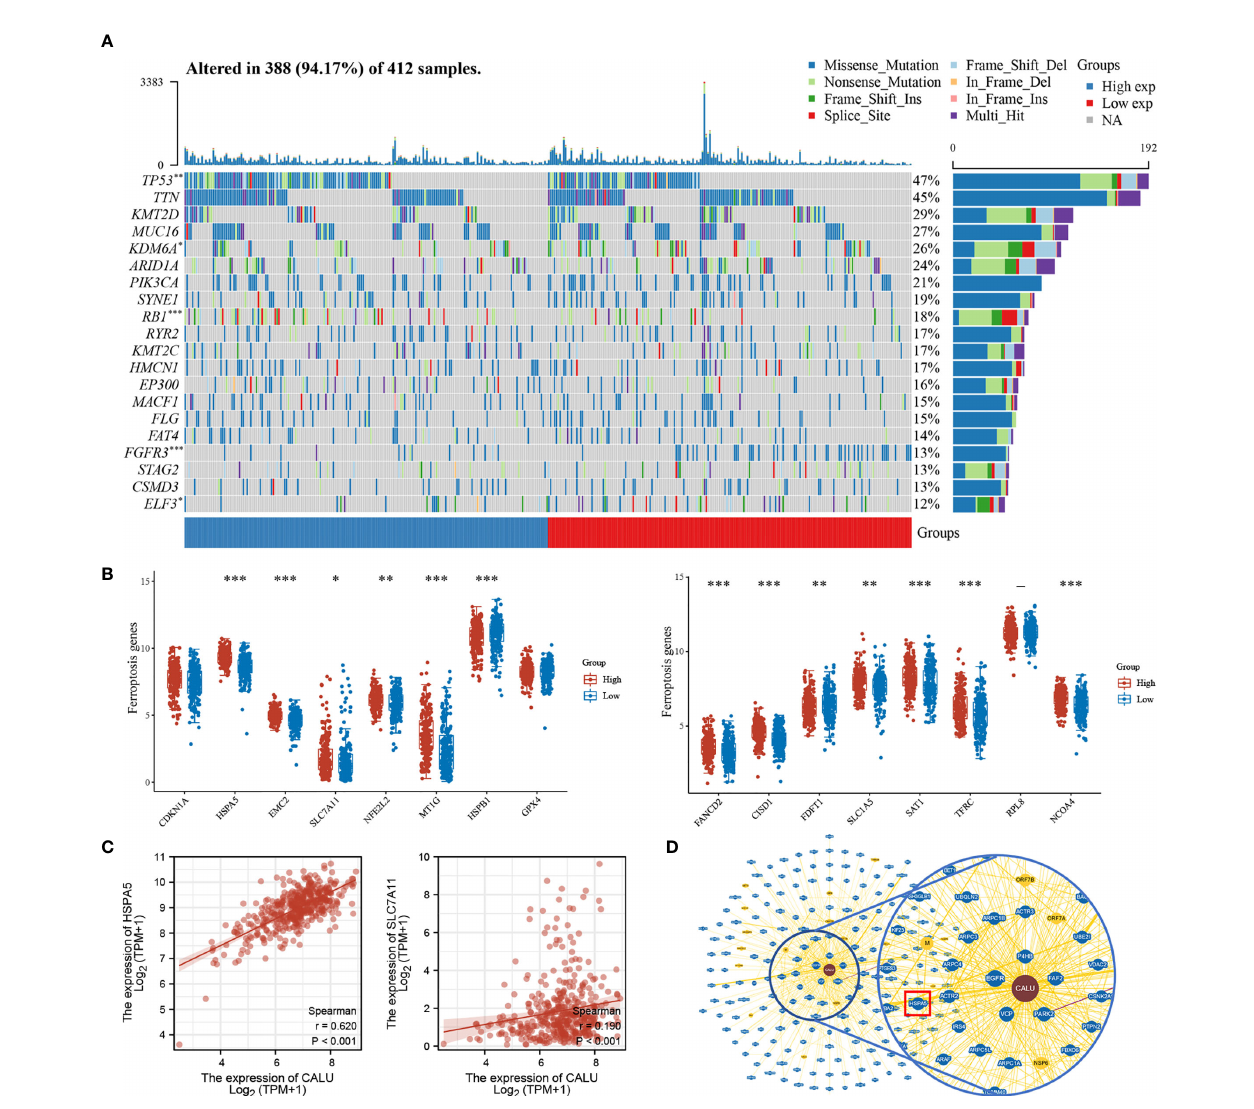
FIGURE 7 | Association of CALU with gene mutations and ferroptosis in BLCA. (A) Signi fi cant differences in mutation frequency of TP53, RB1, FGFR3 between CALU high and CALU low groups, with higher TP53(p<0.01), RB1(p<0.001) and lower FGFR3 (p<0.001), ELF3 (p<0.05) mutation rates in CALU high groups. (B, C) CALU correlates with various of ferroptosis-related genes, including HSPA5 (p<0.001, R=0.620)and SLC7A11 (p<0.001, R=0.190). (D) The protein-protein interaction network from the BioGRID database con fi rmed the interaction between CALU and HSPA5. ***p<0.001, **p<0.01,